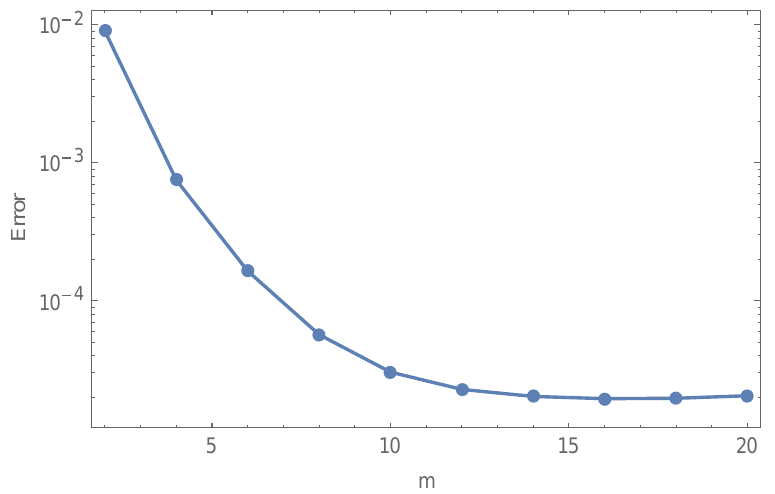
Figure 5. Residual error via order of approximation.